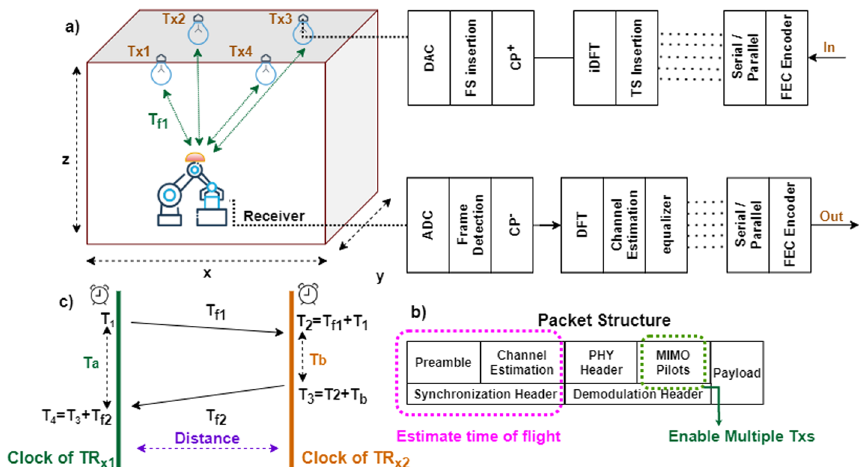
Fig. 4 a c Principle of LiFi-based positioning, b signal +